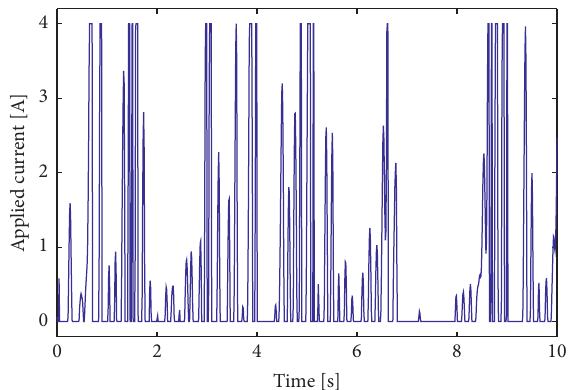
Figure 19: Current input for the system with the proposed